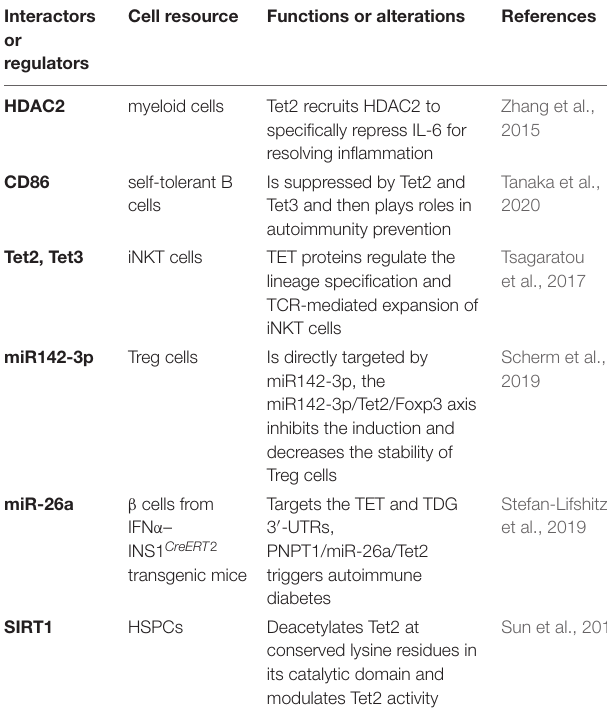
TABLE 1 | Summary of the currently identified Tet2-interacting